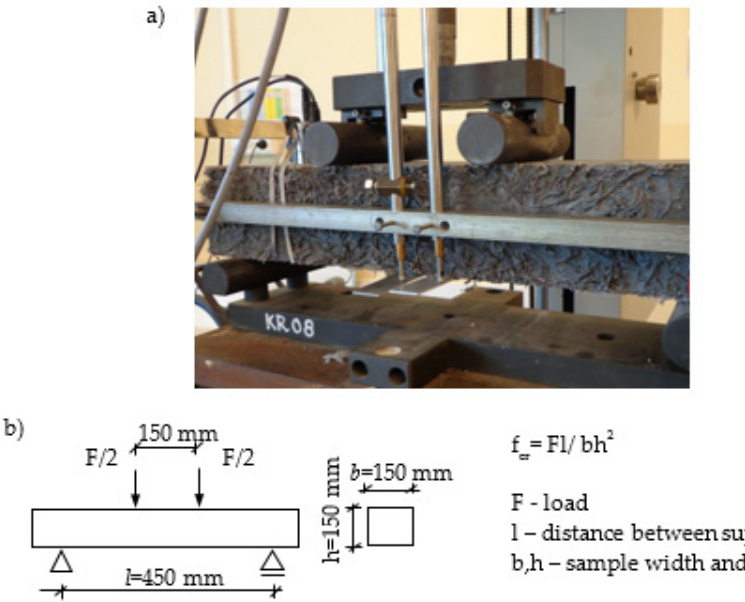
Figure 2. Four-point bending test. ( a ) Specimen before test, paste V f = 6%; ( b ) Diagram of the